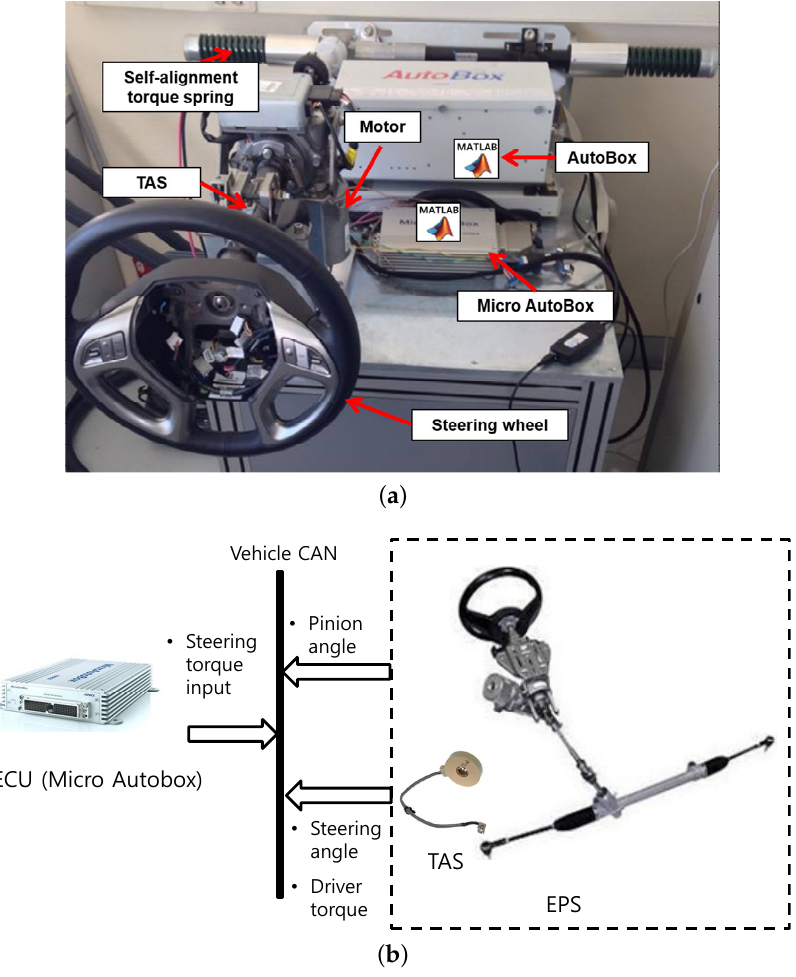
Figure 5. EPS HILS system for experimental verification of SWA controller (CAN, controller area network; ECU, electronic control unit; TAS, torque and angle sensor): ( a ) Photo of the EPS HILS system; ( b ) Block diagram of the EPS HILS